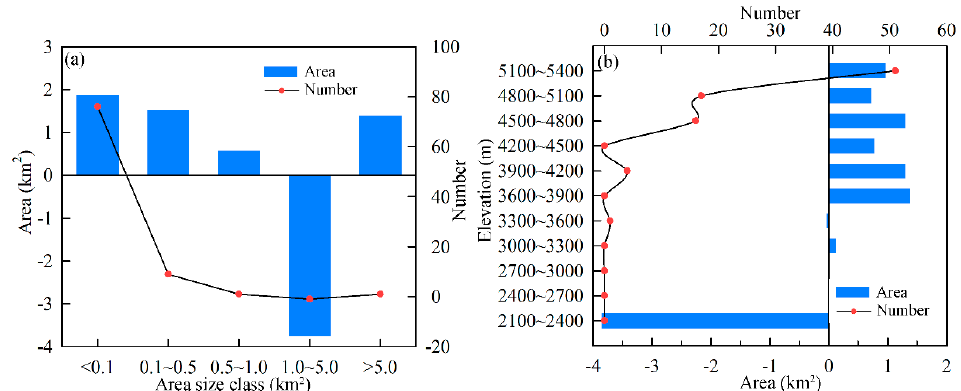
Figure 4. Changes of glacial lakes in different area size classes and elevation intervals of the Yi’ong Zangbo River Basin between 1970 and 2016 (( a ) number and area change of glacial lakes in different area size classes and ( b ) in different elevation intervals.).